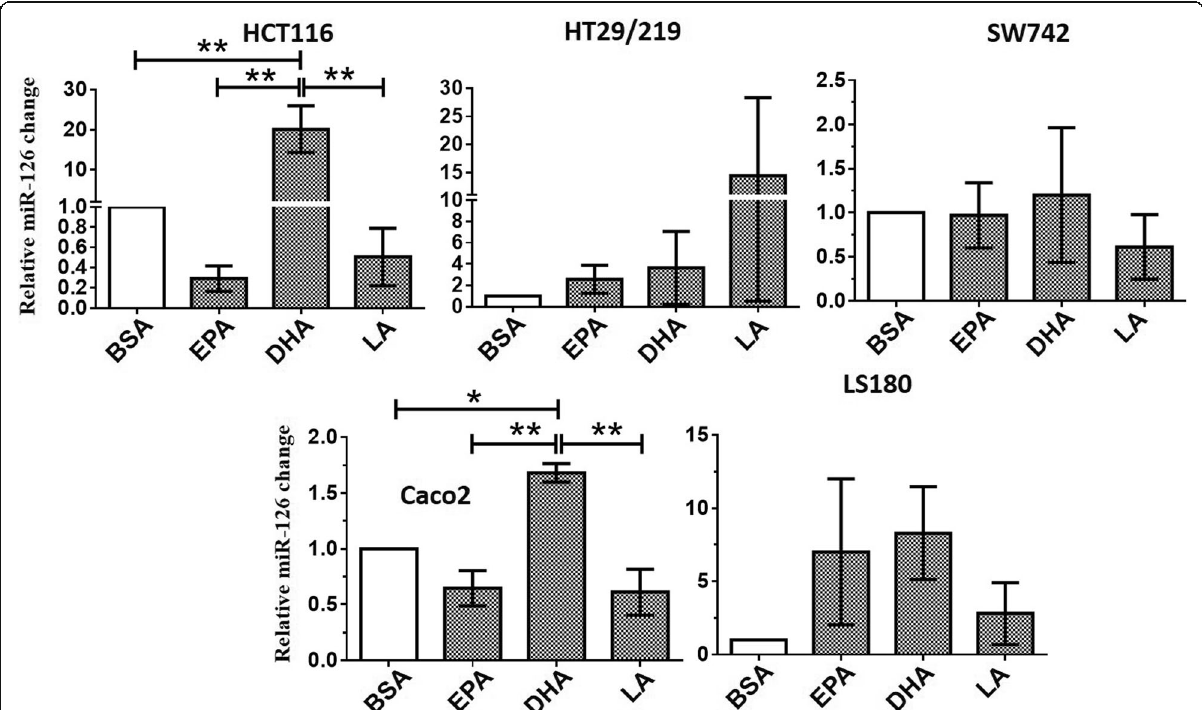
Fig. 2 Comparison of the relative expression of miR-126 in PUFA-treated and control cells, measured by quantitative real-time-PCR. Expression of miR-126 was normalized to U6 snRNA. BSA-treated cells were used as a control and expressions in all other PUFA-treated cells were expressed as an n -fold difference relative to controls (BSA). Mean values ± SD of the three experiments are given. Bars marked with an asterisk are significantly different as verified by Tukey ’ s honestly significant difference multiple comparison test ( p < 0·05). EPA, eicosapentaenoic acid; LA, linoleic acid;